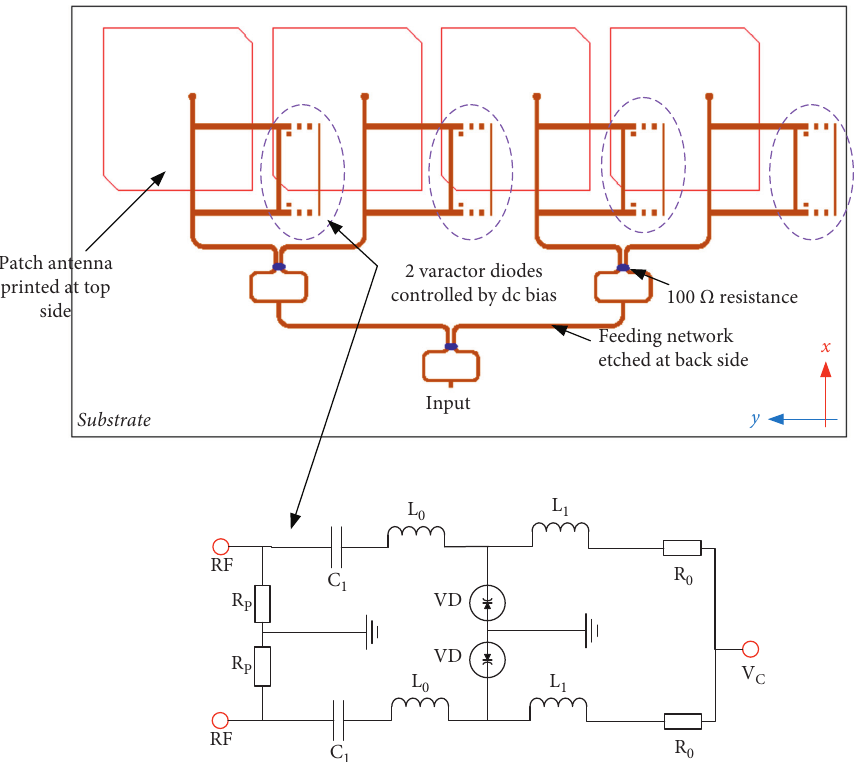
Figure 1: Geometrical configuration of the proposed pattern reconfigurable antenna